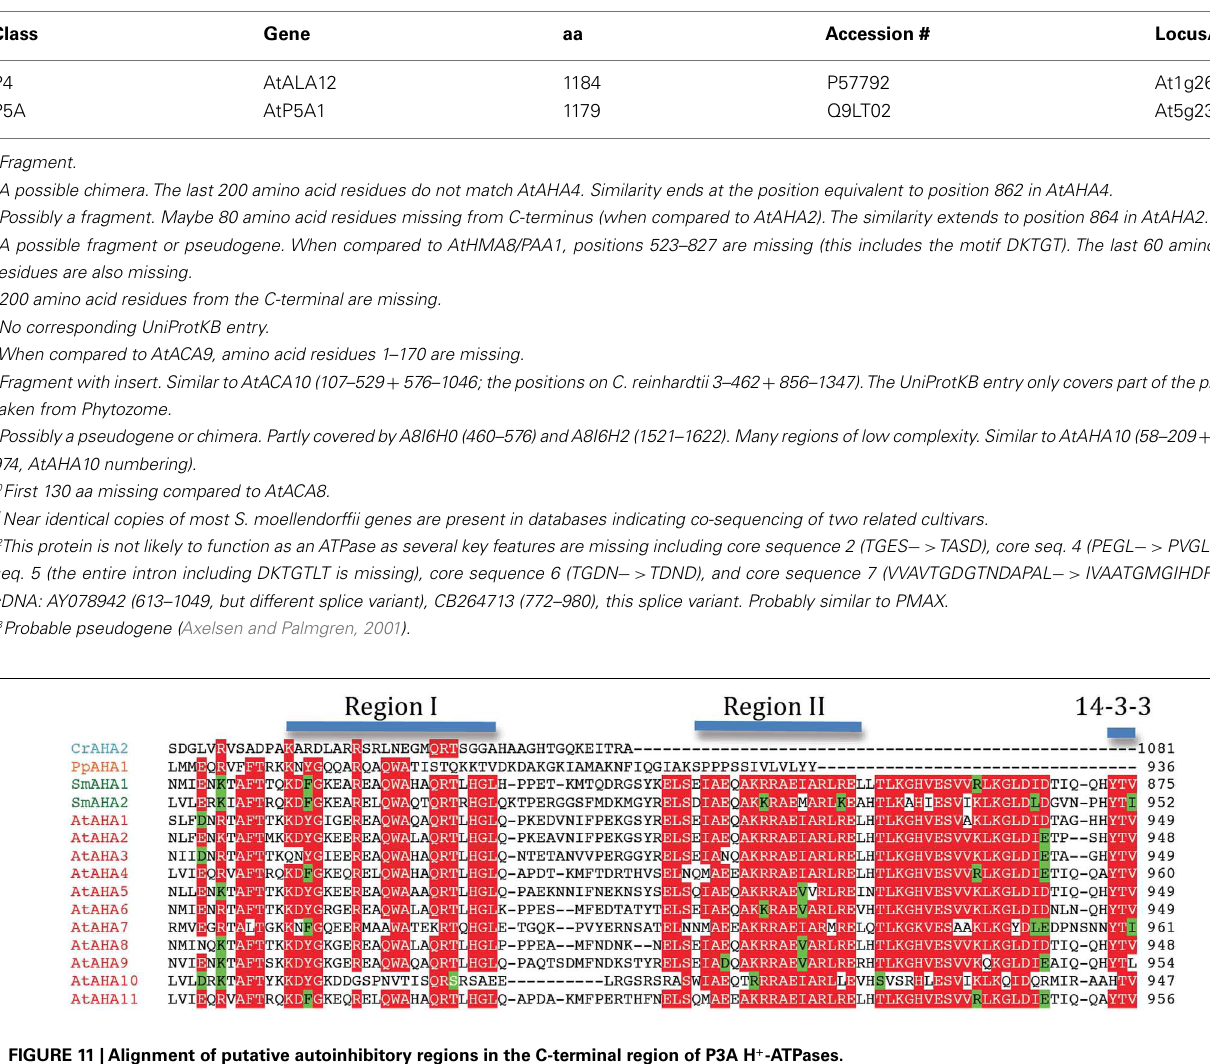
it is a resident of the trans Golgi of root tip cells where it is con- nected to the generation of secretory vesicles leaving the Golgi apparatus (Poulsen et al.,